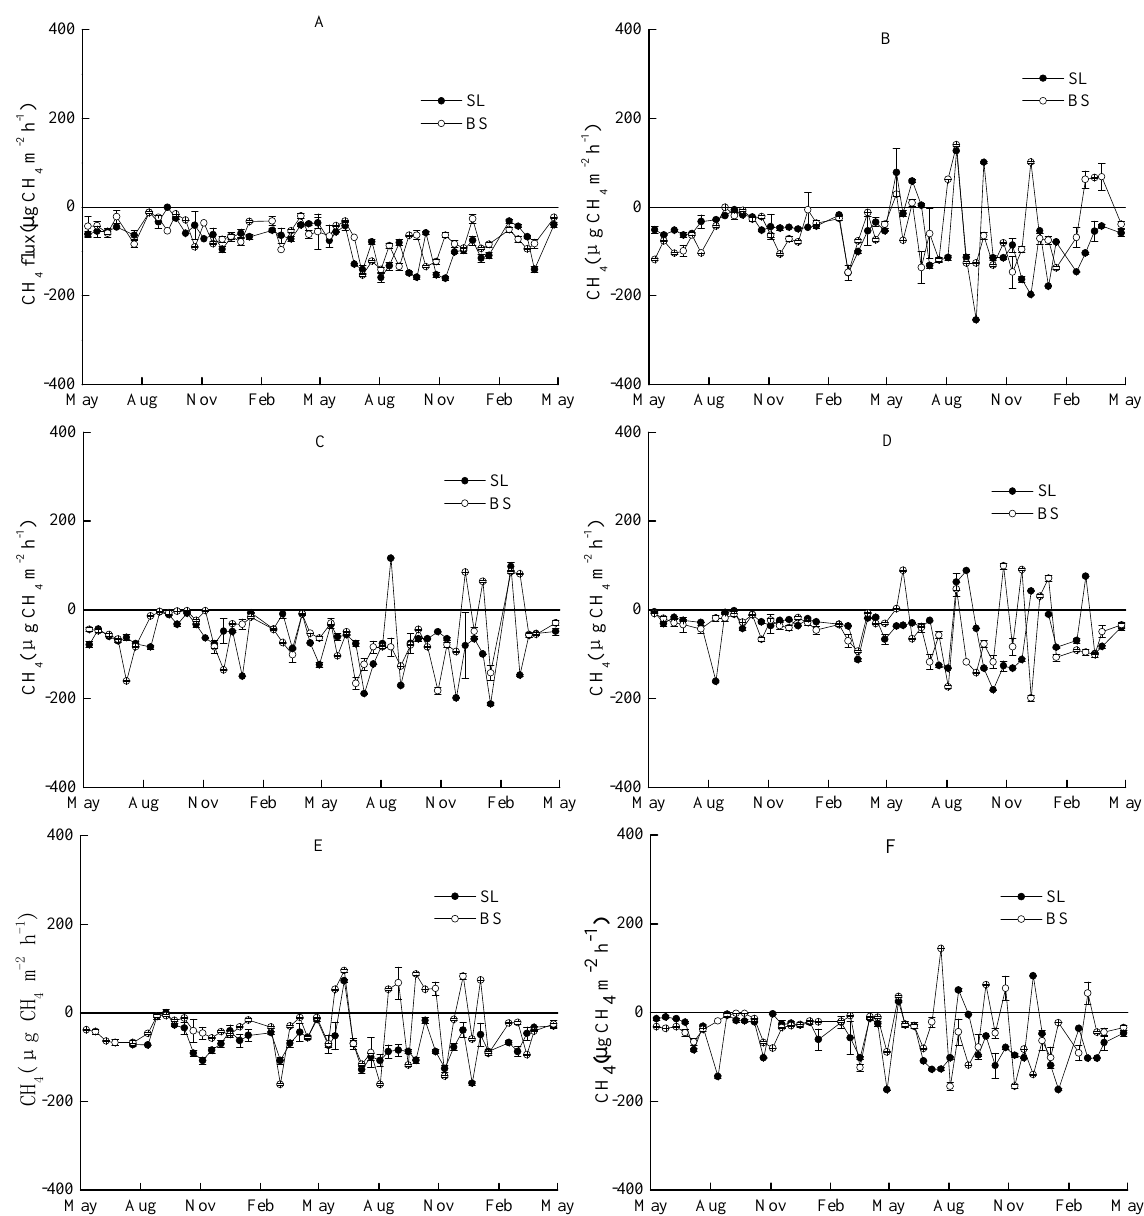
Fig. 4 Fig. 4. Seasonal patterns of CH 4 flux rates measured in six tree species on Taihang Mountain with (SL) or without (BS) surface litter from May 2010 to April 2012. The tree species are (A) Robinia pseudoacacia , (B) Vitex negundo var. heterophylla , (C) Leptodermis oblonga , (D) Punica granatum , (E) Ziziphus jujube , and (F) Bothriochloa ischcemum . The error bars represent standard errors ( n = 3).